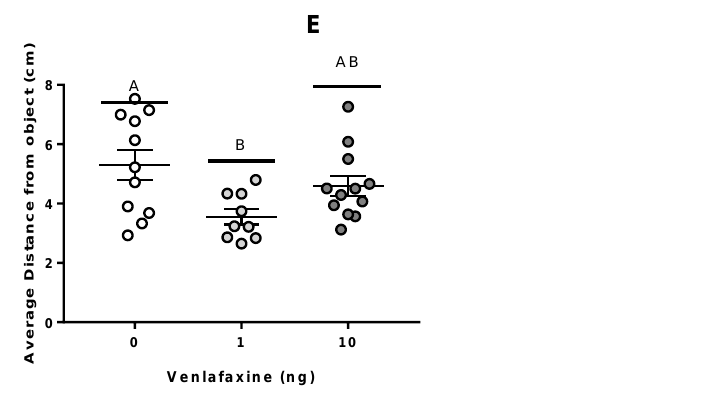
Figure 3. Behavioural assessment of juvenile fish. Behavioural responses of juvenile fish in lateral view ( A , B ), open field ( C , D ) or novel object assessments ( E ). Zebrafish were originally exposed to 0, 1, or 10 ng venlafaxine at the 1–4 cell stage. All assessments were recorded for 5 min. The novel object assessment occurred immediately after the open field assessment by the addition of an air stone directly into the middle of the arena ( n = 9–13). Different letters denote significant differences between groups.